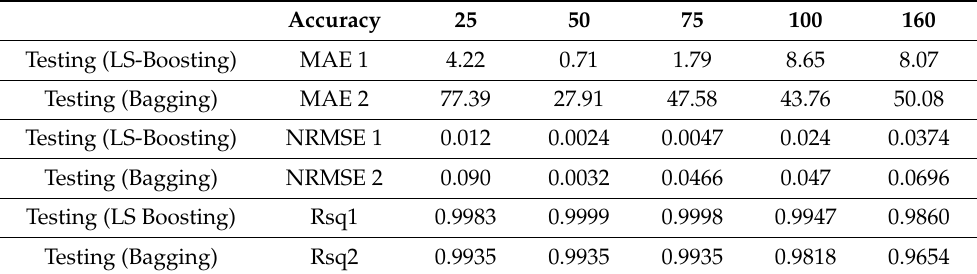
Table 7. Throughput data testing accuracy using LS-Boosting and